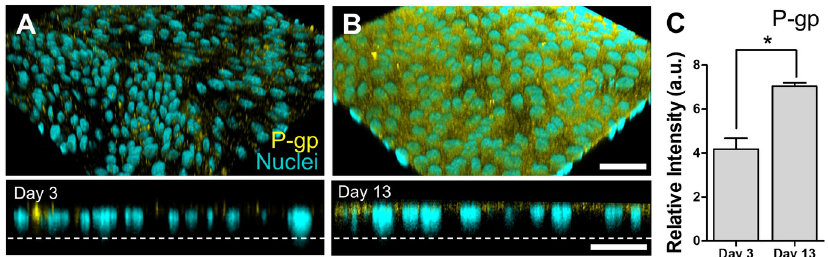
Fig 5. Expression of the P-gp in the canine colonoid-derived monolayer. The expression of P-gp was visually characterized by IF staining. Angled (upper) and cross-sectional side views (lower) show the localization the P-gp proteins (Yellow) on the polarized colonoid-derived monolayer at days 3 ( A ) and 13 ( B ), respectively. Nuclei, Cyan. Dashed lines pinpoint the location of the basement membrane in the nanoporous insert. Bars, 50 μ m. ( C ) Quantification of the P-gp expression at days 3 and 13, respectively. Total 10 randomly chosen fields of view were used to detect P-gp expression levels among 4 biological replicates. In each biological replicate, we performed 2 technical replicates. a.u., arbitrary unit. Error bars indicate SEM. � P <